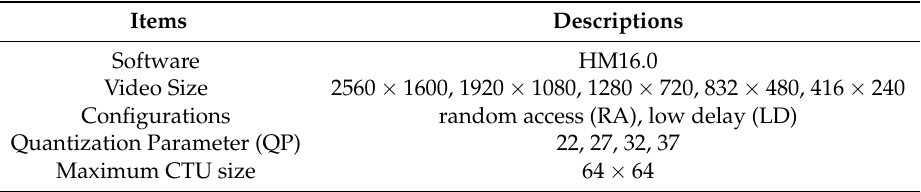
Table 2. The simulation